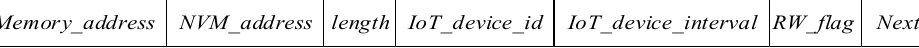
Figure 2. Structure of Tio.